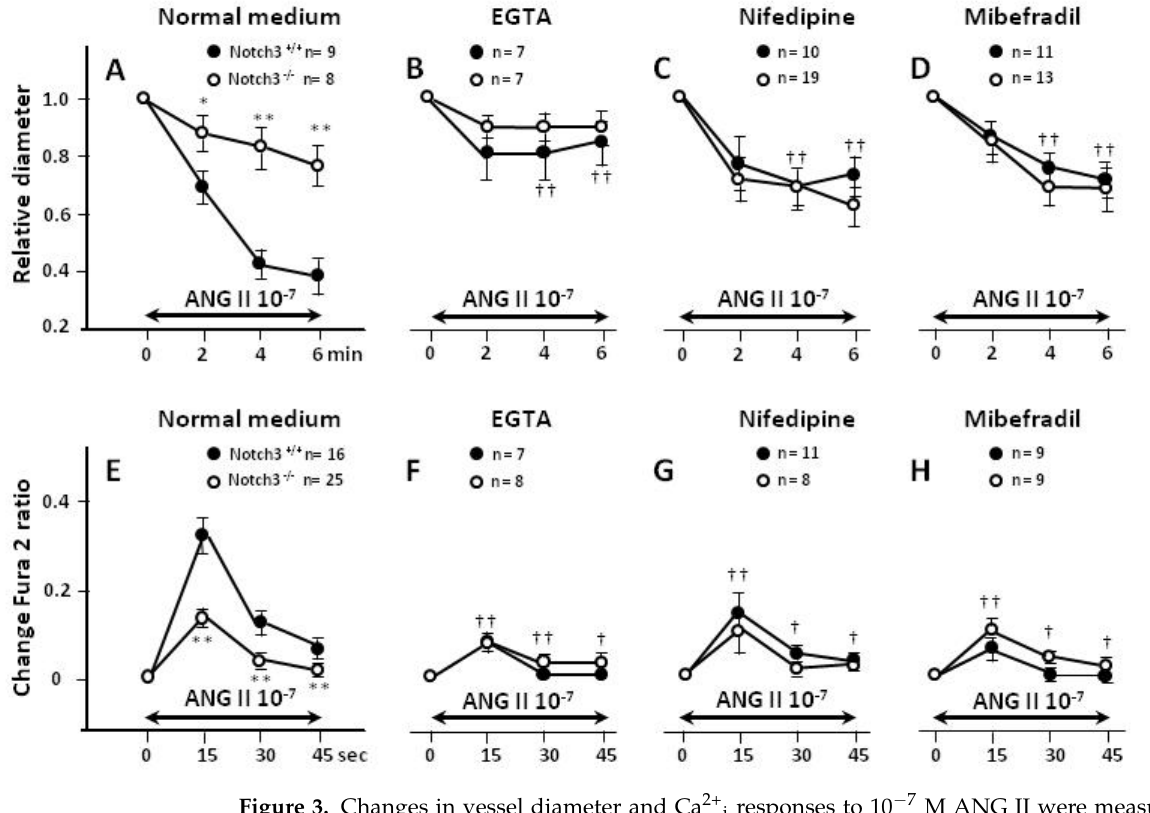
Figure 3. Changes in vessel diameter and Ca 2+i responses to 10 − 7 M ANG II were measured in fura- 2-loaded vessels freshly isolated from wild-type and Notch3 − / − mice. In normal medium, both diameter ( A ) and the Ca 2+i response ( E ) were reduced in AAs lacking Notch3 expression. This strain difference in contractile and Ca 2+i responses disappeared when Ca 2+ was removed from the medium with EGTA ( B , F ), when L-type Ca 2+ channels (Ca v 1.2) were blocked with nifedipine ( C , G ), or when T-type Ca 2+ channels (Ca v 3.2) were blocked with mibefradil ( D , H ). It is noteworthy that the effect of these agents, which essentially target Ca 2+ entry, is negligible on renal-resistant vessels from Notch3 − / − mice. *, ** p < 0.05 and p < 0.01, respectively, vs. WT. †, †† p < 0.05 and p < 0.01, respectively, vs. corresponding response in normal medium.